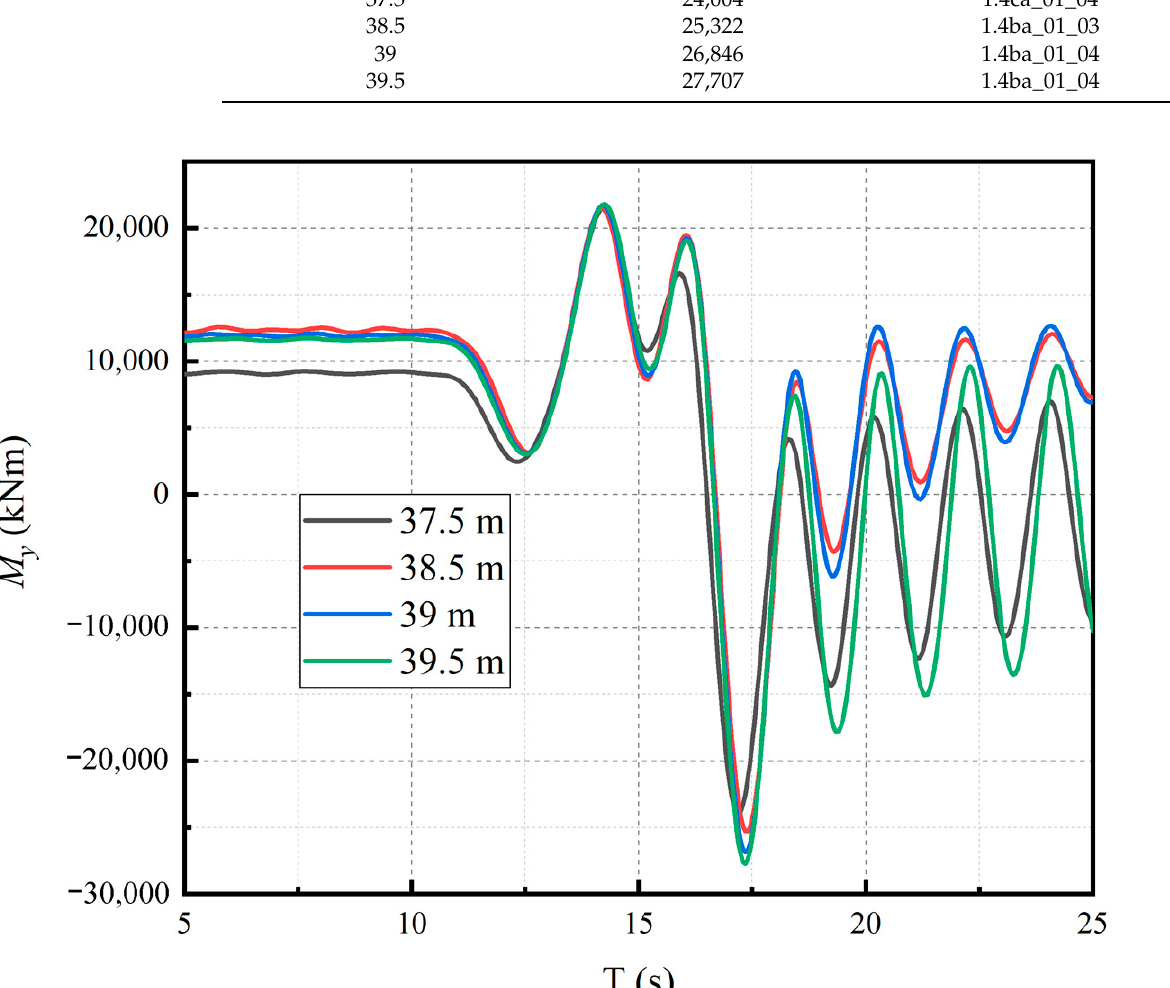
Table 13. Ultimate loads at blade root.